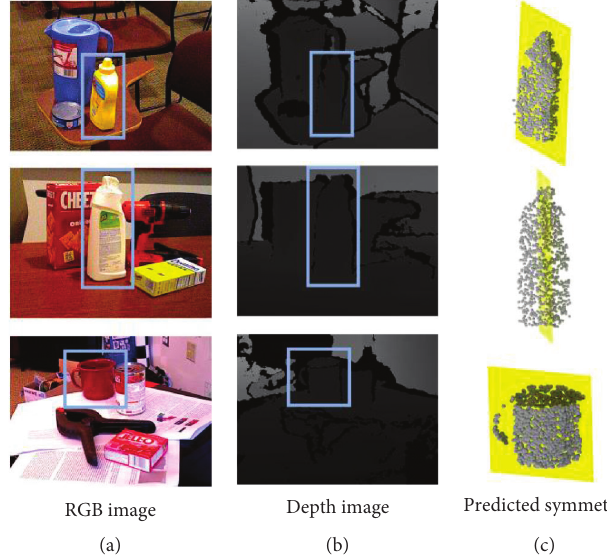
Figure 4: Qualitative results of the predicted symmetry on the YCB-Video